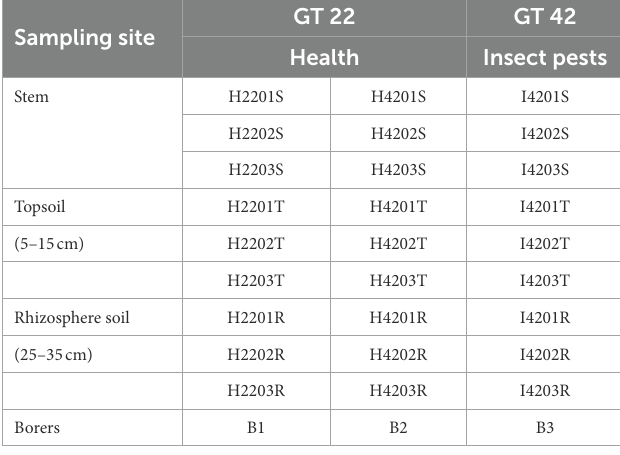
TABLE 1 Design and samples of the